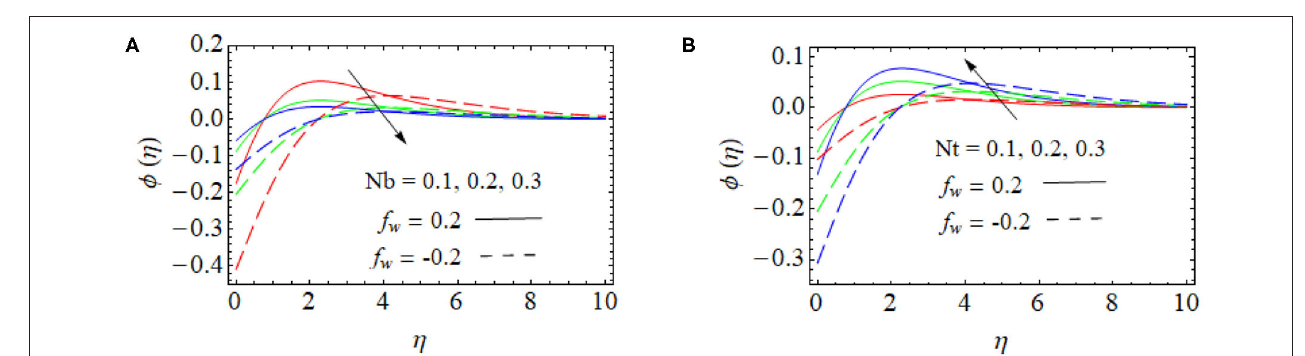
FIGURE 5 | (A,B) Impact of Nb and Nt on concentration profile φ ( η